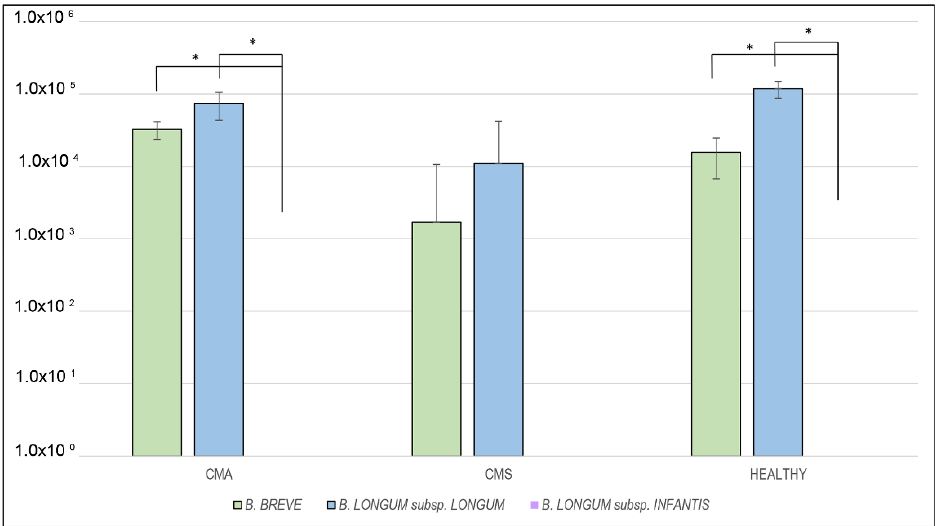
Figure 1. Median differences between B. breve , B. longum subsp. longum and B. longum subsp. infantis levels expressed as molecules/ul at T 0 for the three analyzed groups (* p < 0.05).